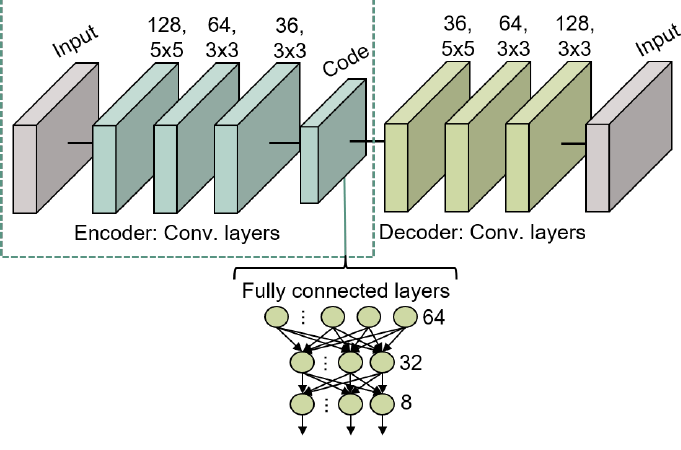
Figure 10. Convolutional Autoencoder structure for gesture recognition.